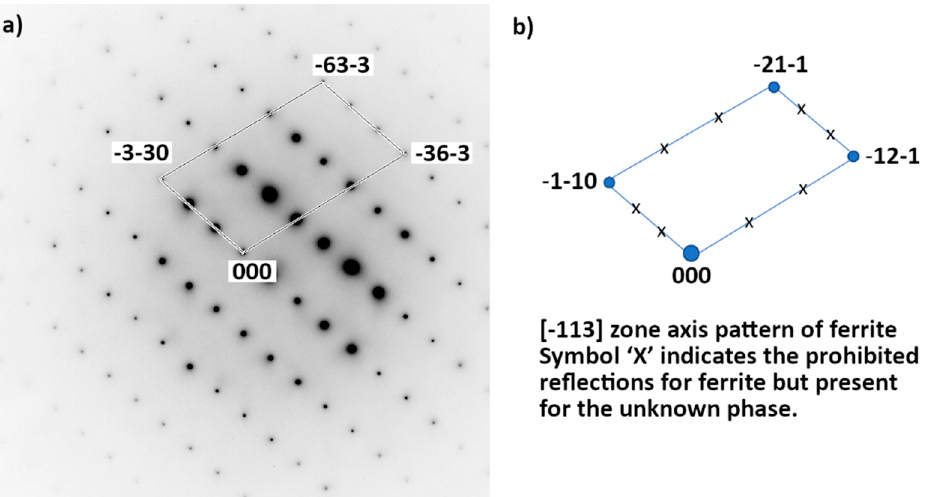
Table 3. Concentrations (wt%) of the main chemical elements in the different phases and compari- son with equilibrium composition. In bold are the measured data having discrepancies with the equilibrium compositions. The value with (*) has been measured in a SEM with a wavelength dis- persive X-ray analysis (WDX), using a LSM80E Ni–C crystal, at 5 kV in order to reduce the interac- tion volume.